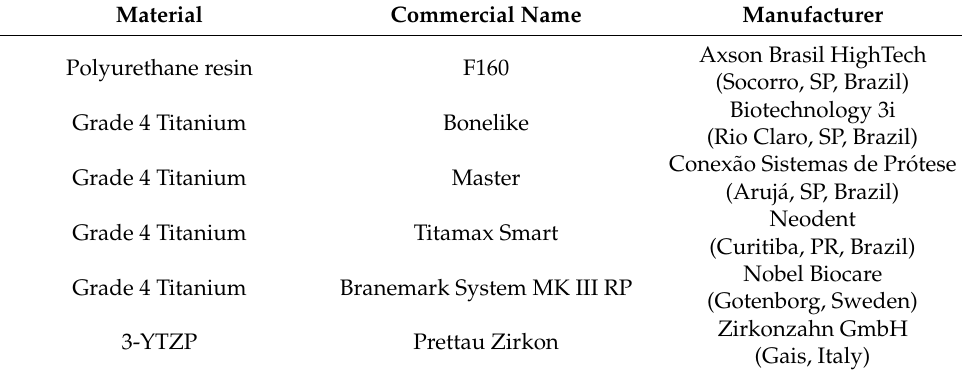
Table 1. Materials used in the study 1